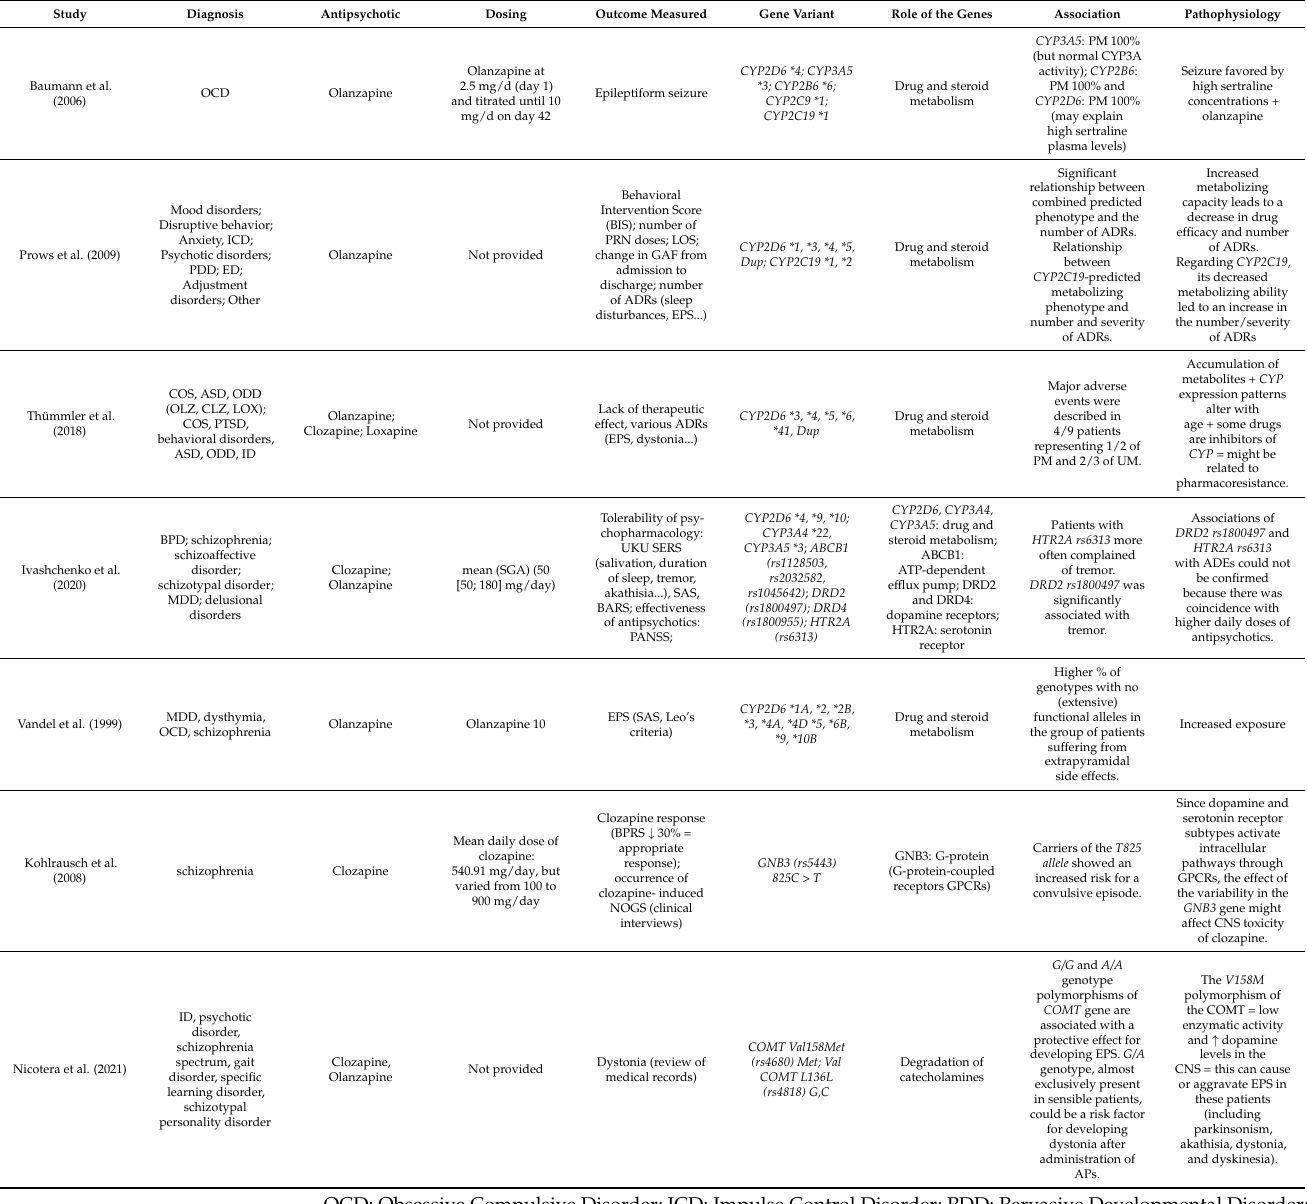
Table 4. Synthesis of studies investigating neurological adverse drug